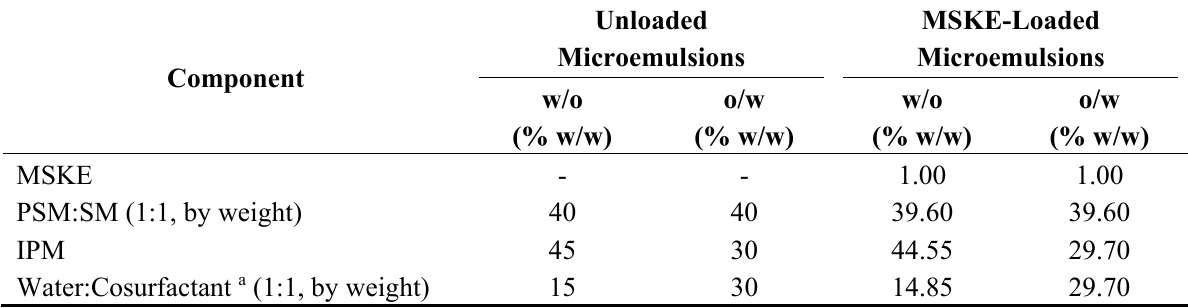
Table 6. Compositions of unloaded and MSKE-loaded